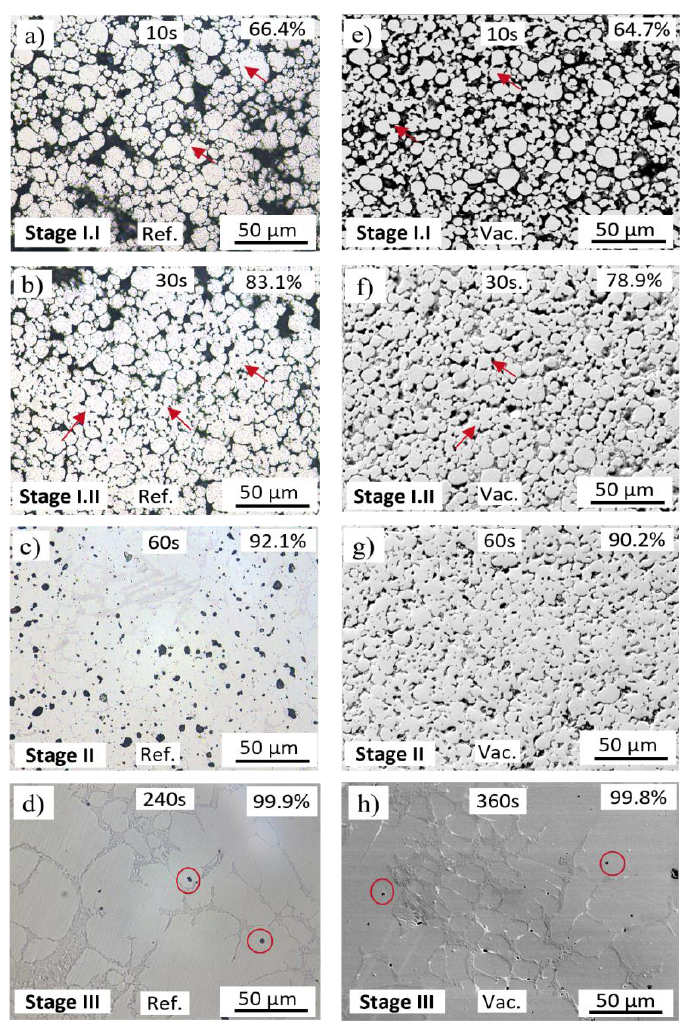
Figure 7. Micrographs of the indirect induction sintered FFF 316L stainless steel in the refractory ballast after ( a ) 10 s, ( b ) 30 s, ( c ) 60 s, and ( d ) 240 s, and sintered in the vacuum tube after ( e ) 10 s, ( f ) 30 s, ( g ) 60 s, and ( h ) 360 s.